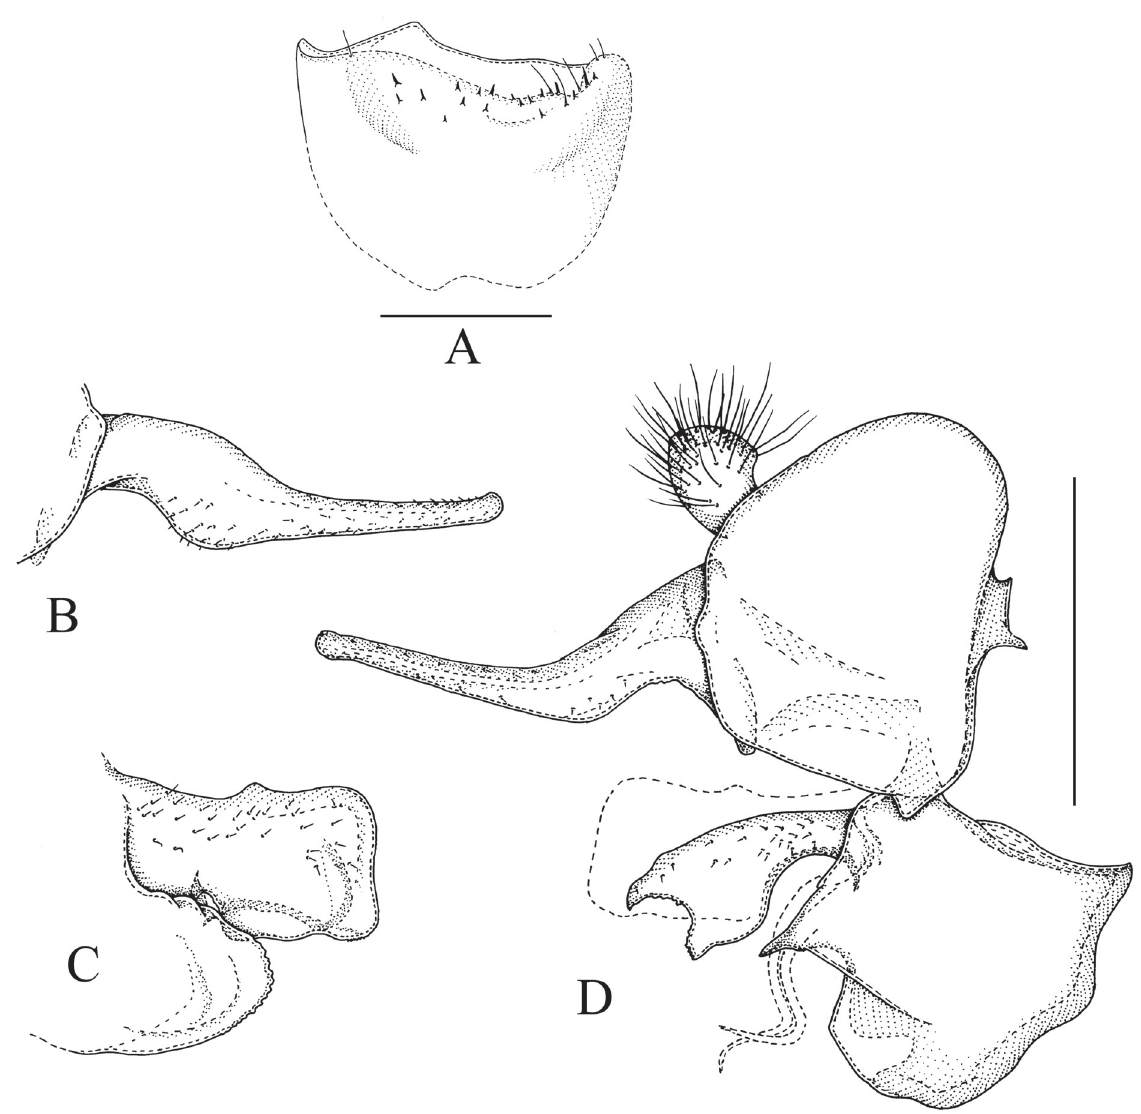
Fig. 87. Sphegina (Asiosphegina) strigillata sp. nov., holotype, ♂ . A . Sternum IV, ventral view. B . Left surstylus, lateral view. C . Left superior lobe with associated parts, lateral view. D . Genitalia, right side, lateral view. Scale bars = 0.5